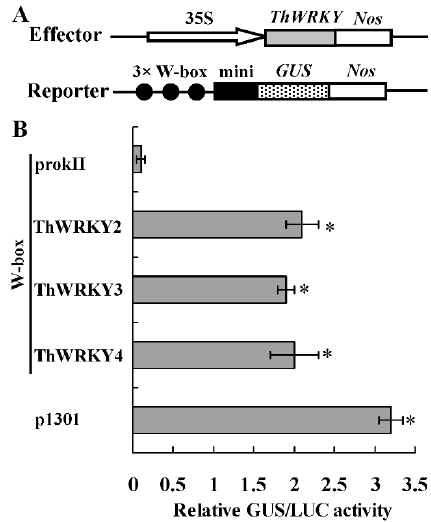
Figure 3. Analysis of the binding of ThWRKY2, ThWRKY3, and ThWRKY4 to the W-box motif in plants. ( A ) Diagram of the reporters and effectors. Triple tandem copies of the W-box were fused with the 35S CaMV − 46 minimal promoter and cloned into pCAMBIA1301 for driving the GUS gene as the reporter construct. The CDSs of ThWRKY s into pROKII under the control of the 35S promoter as the effector constructs; ( B ) GUS activity assay of the co-expression of effector and reporter plasmids in tobacco leaves. Each effector and the reporter constructs were co-transformed into tobacco leaves. The 35S-luciferase construct was transformed together with the reporter and effector into leaves to normalize for transformation efficiency. The error bars were standard deviations, which were calculated from three independent biological repeats. * indicates a significant difference ( p < 0.05).